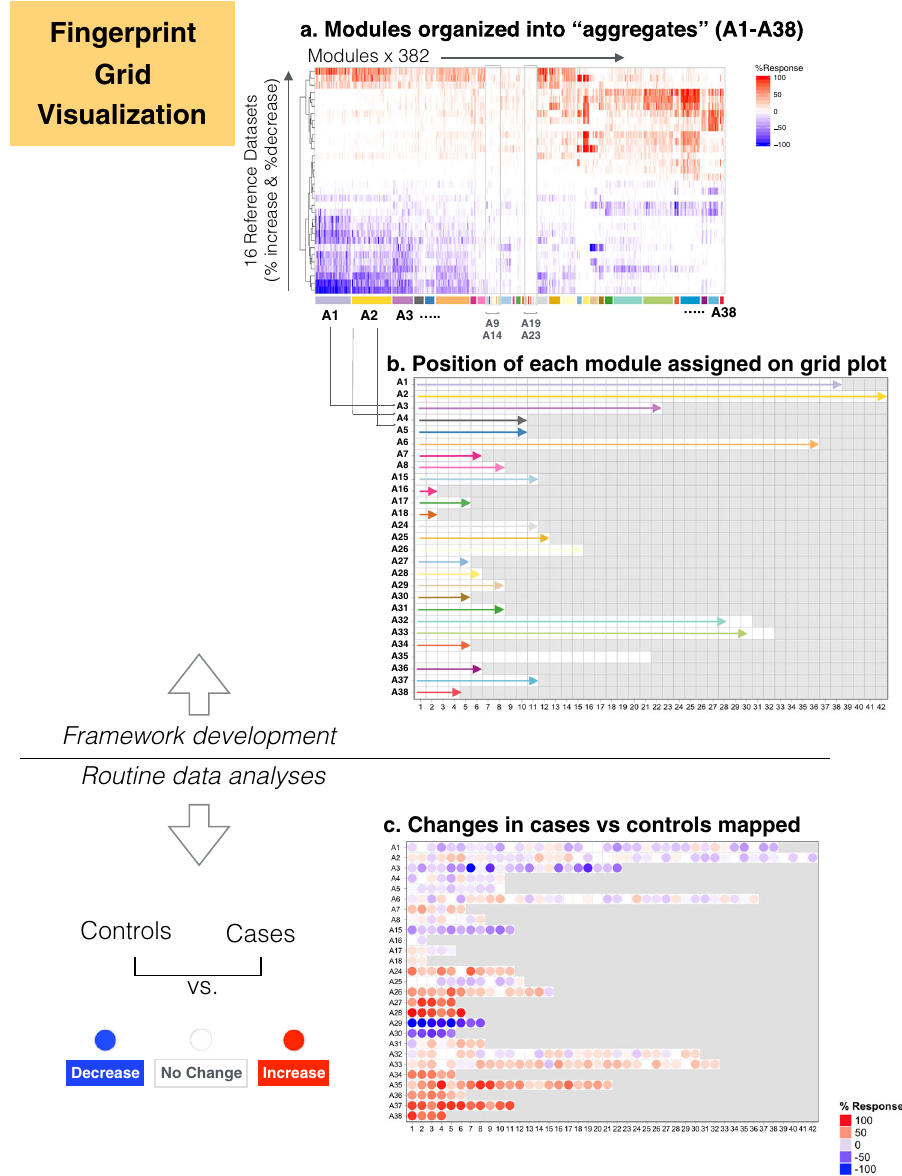
Fig. 2 The development of the BloodGen3 module fi ngerprint grids. a Rows on this heatmap correspond each to changes in transcript abundance for a given dataset and for a given direction (i.e. increase or decrease in transcript abundance). These values, the percentages of constitutive probes either increased or decreased within a module, are computed for the 16 datasets used as input for module construction (Table 1). Increases in transcript abundance compared to a healthy baseline are depicted in red and decreases are depicted in blue. Therefore, in total 32 rows are displayed on this heatmap. Columns correspond to modules comprising the BloodGen3 repertoire ( N = 382). The colors shown on the bottom track are associated with module aggregate ID and only serve to illustrate the strategy that was employed for organization of modules on the fi ngerprint grid plot. b The modules were arranged onto the grid as follows: the master set of 382 modules was partitioned into 38 clusters (or aggregates) based on similarities among their module activity pro fi les across the sixteen reference datasets (A1 – A38). A subset of 27 aggregates comprising two or more modules in turn occupied a line on the grid. The length of each line was adapted to accommodate the number of modules assigned to each cluster. The format of the grid was fi xed for all analyses carried out using the BloodGen3 module repertoire. c When performing downstream analyses of blood transcriptome datasets using the BloodGen3Module R package changes in transcript abundance at the module level are mapped onto this grid and represented by colored spots of varying